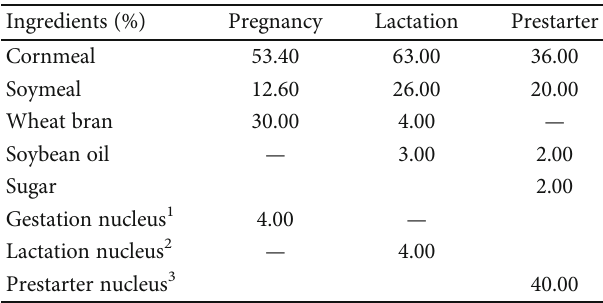
Table 1: Ingredients for sows in pregnancy and lactation and suckling